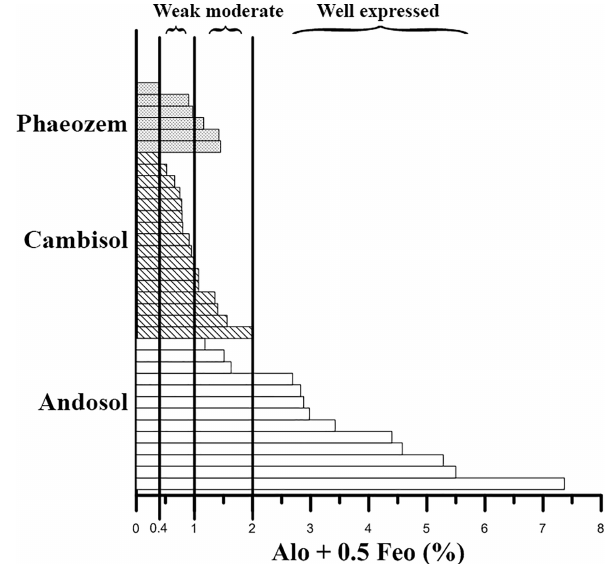
Figure 2. Soil type (IUSS Working Group, WRB, 2015) plot- ted against Al o + 0 . 5Fe o % (weighted mean according to horizon thickness for each of the studied pedons). The value of 0.4% in Al o + 0 . 5Fe o is the “key out” requirement for entering in the An- dosol (and/or Andisol) classes both in WRB (IUSS Working Group WRB, 2015) and USDA Soil Taxonomy (SSS, 2014) classifications. The Al o + 0 . 5Fe o index can be considered weak in the range